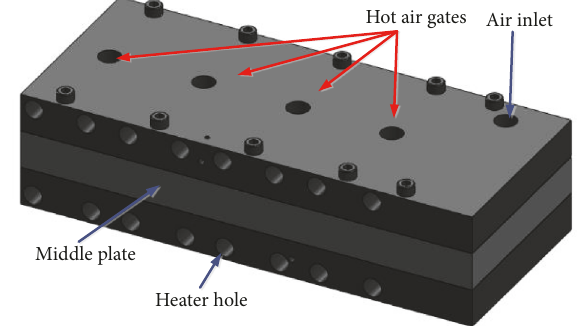
Figure 3: Air drier component parts.